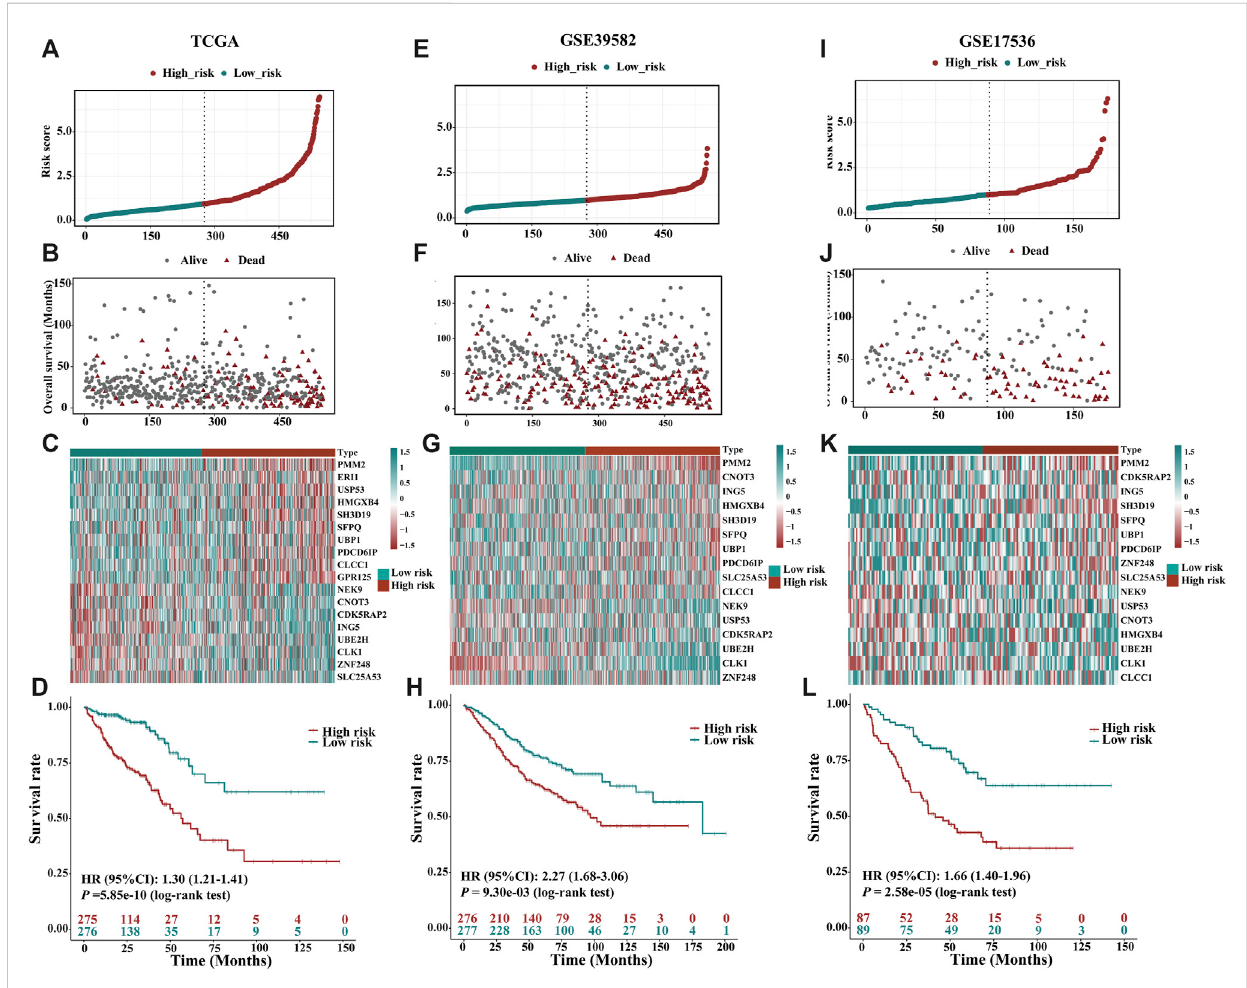
FIGURE 3 Prognosticvalueoftheriskpatternsofthe18m6A-relatedgenesignaturesintheTCGAtrainingdataset,GSE39582andGSE17536validationdataset. (A) Distribution of m6A-related gene expression model-based risk score for TCGA. (B) Different patterns of survival status and survival time between the high- and low-risk subgroups for TCGA. (C) Clustering analysis heatmap shows the expression standards of the 18 prognostic genes for each patient for TCGA. (D) Kaplan-Meier survival curves of the OS of patients in the high- and low-risk subgroups for TCGA. (E) Distribution of m6A-related gene expression model-basedriskscore for theGSE39582. (F) Differentpatternsofsurvivalstatusand survival timebetweenthehigh- andlow-risk subgroups for the GSE39582. (G) Clustering analysis heatmap shows the expression standards of the 18 prognostic genes for each patient for the GSE39582. (H) Kaplan-Meiersurvivalcurvesof theOSof patients inthehigh-and low-risk subgroups for theGSE39582. (I) Distribution ofm6A-relatedgene expression model-based risk score for the GSE17536. (J) Different patterns of survival status and survival time between the high- and low-risk subgroups for the GSE17536. (K) Clustering analysis heatmap shows the expression standards of the 18 prognostic genes for each patient for the GSE17536. ( L ) Kaplan- Meier survival curves of the OS of patients in the high- and low-risk subgroups for the